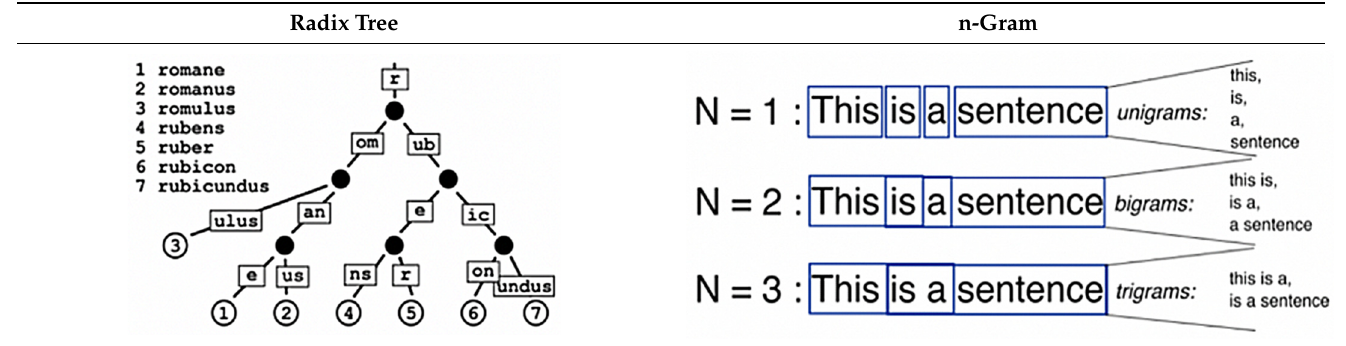
Table 3. The radix tree and n-gram mechanism comparison.